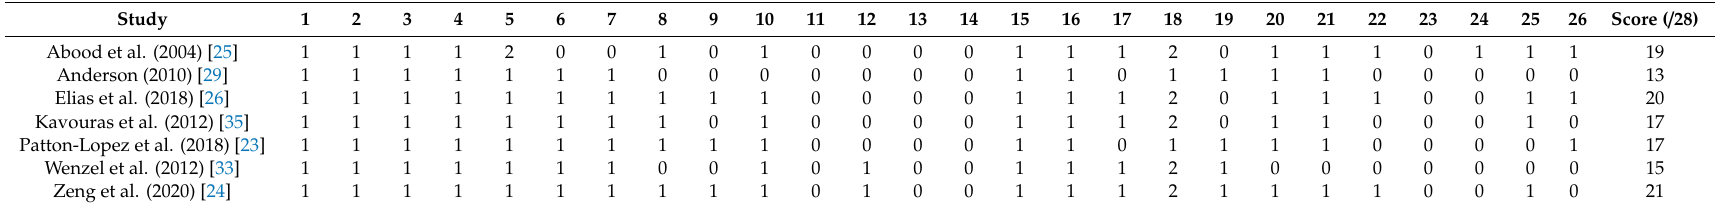
Table 6. Methodologic quality of the included double-arm studies.